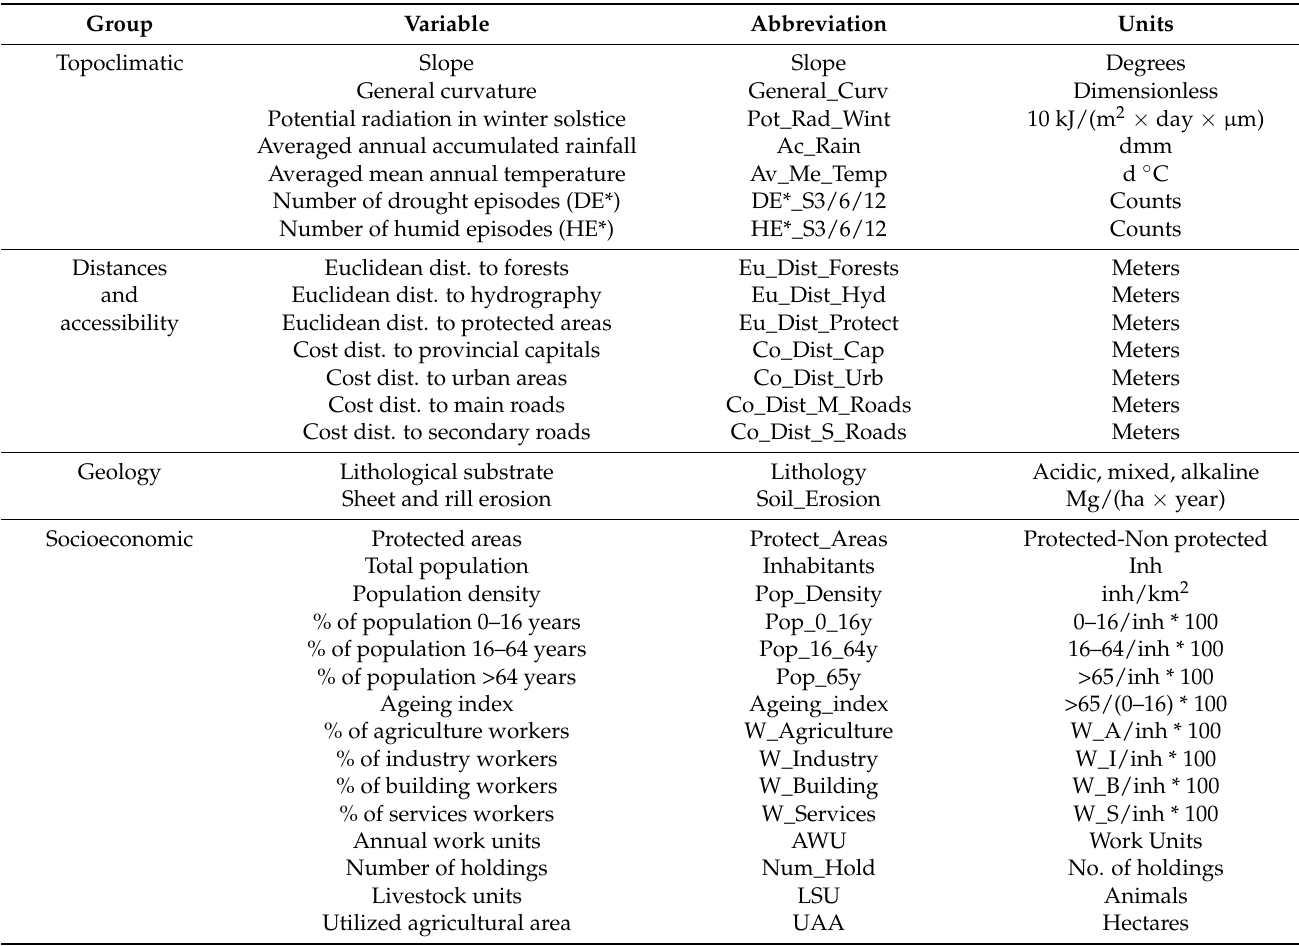
Table 2. Explanatory variables used for modeling forest expansion in the study area. Variables collected at different temporal moments have a value in each period (P1,